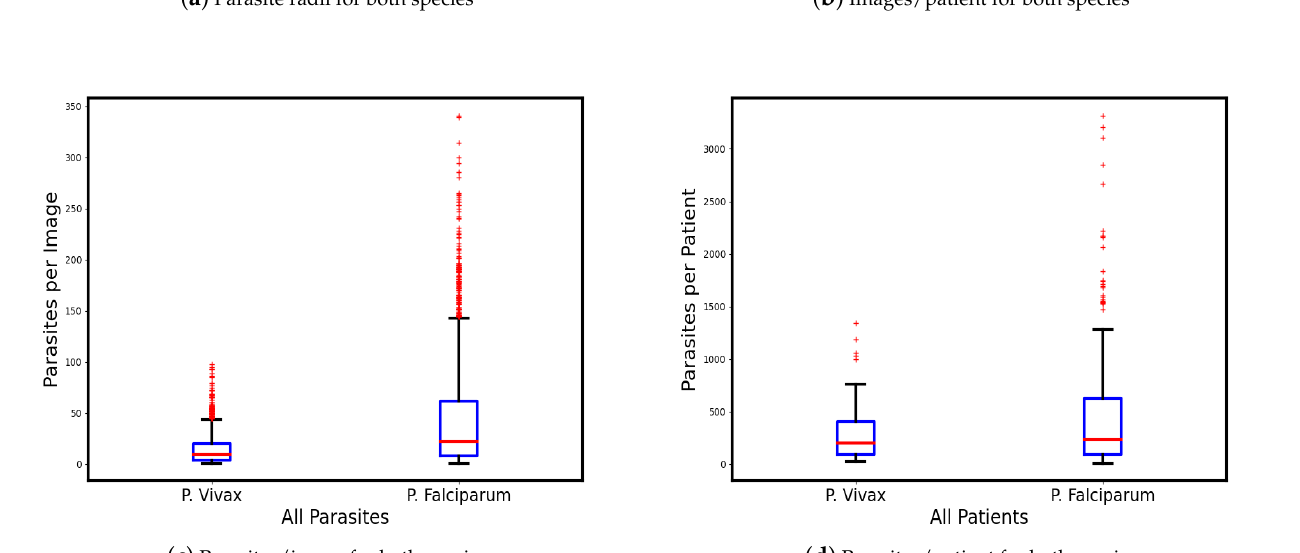
Figure 2. Range comparison of our two parasite datasets in terms of parasite radius ( a ), number of images per patient ( b ), number of parasites per image ( c ), and number of parasites per patient ( d ). The box plots display the boxes’ bottom, median, and top edges for the 25th, 50th, and 75th percentiles, respectively. The outliers are plotted as individual points by a red mark beyond the